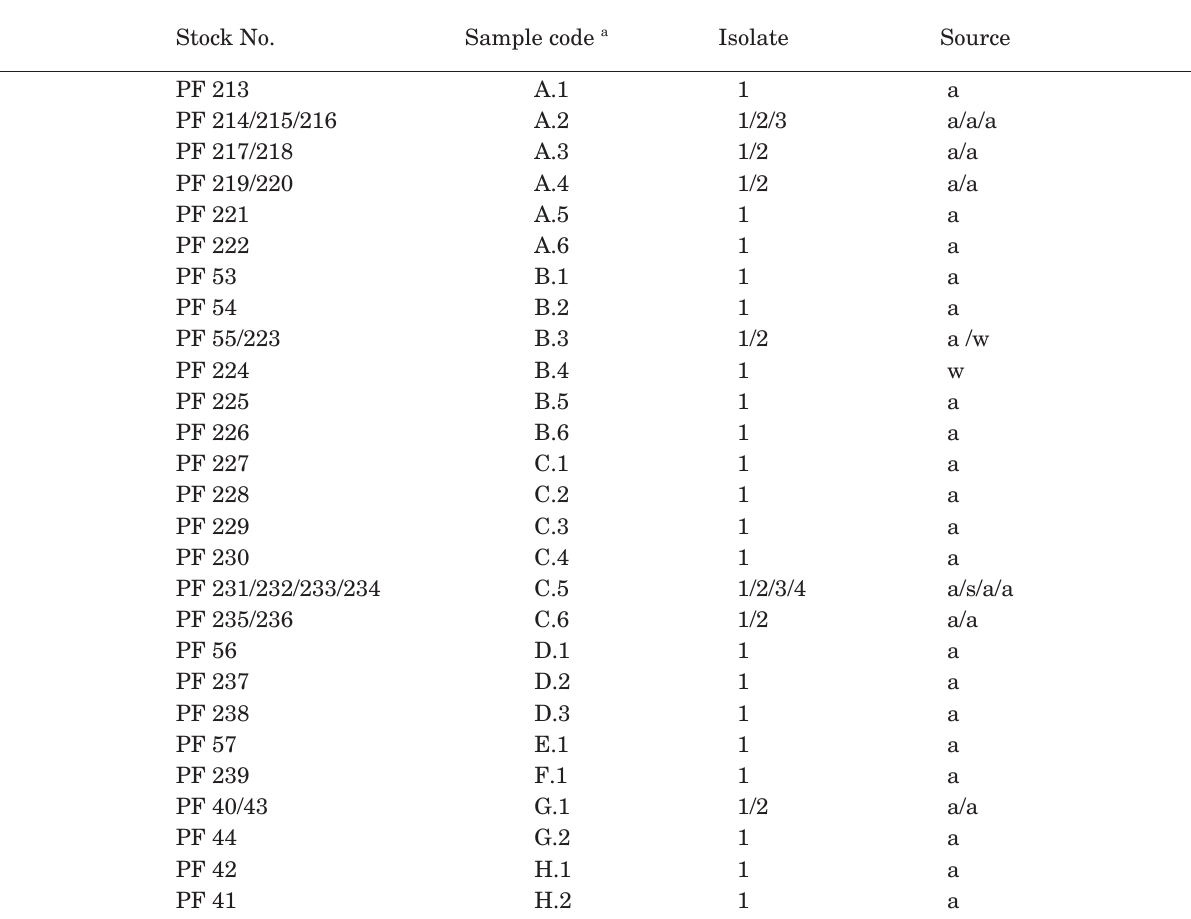
a Capital letters and numbers refer to the site and the host tree respectively, as in the table caption.